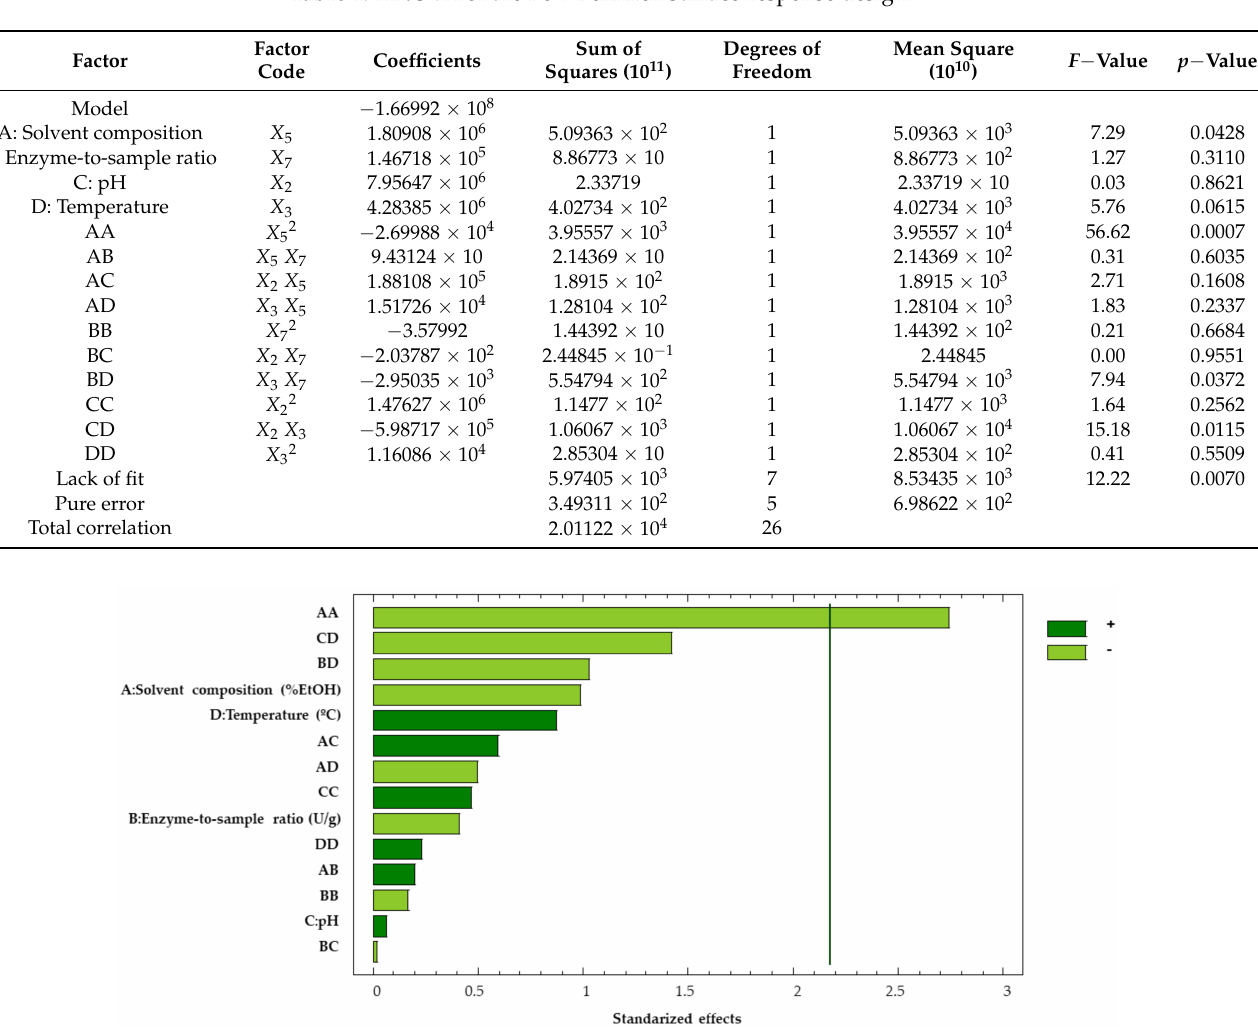
Figure 4. Pareto chart of the Box–Behnken surface-response design. Based on the plot of the main effects in the Box–Behnken design (Figure 5), the optimal value for each factor can be determined. These values are displayed in Table